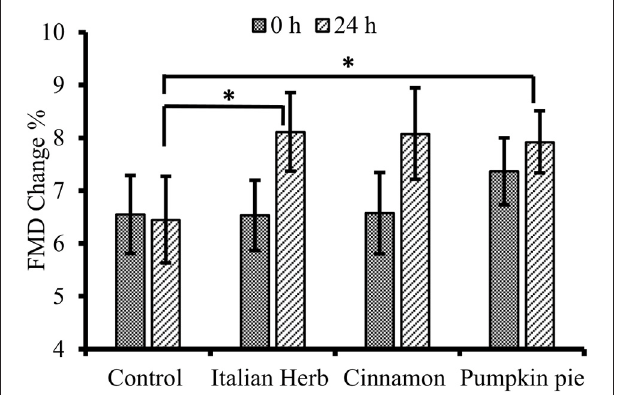
FIGURE 3 | Fasting/baseline flow mediated dilation (FMD) pre-meal (0h) vs. 24h post-challenge meal ( n = 25). Data are means ± standard error of mean (SEM). Data were log-transformed prior to statistical analysis. PROC MIXED (SAS Institute, Inc., Cary, North Carolina) was used for repeated measures. Significant meal by time interaction ( P = 0.04) with main difference at 24h ( P = 0.02). *Significantly different from control, P < 0.05.